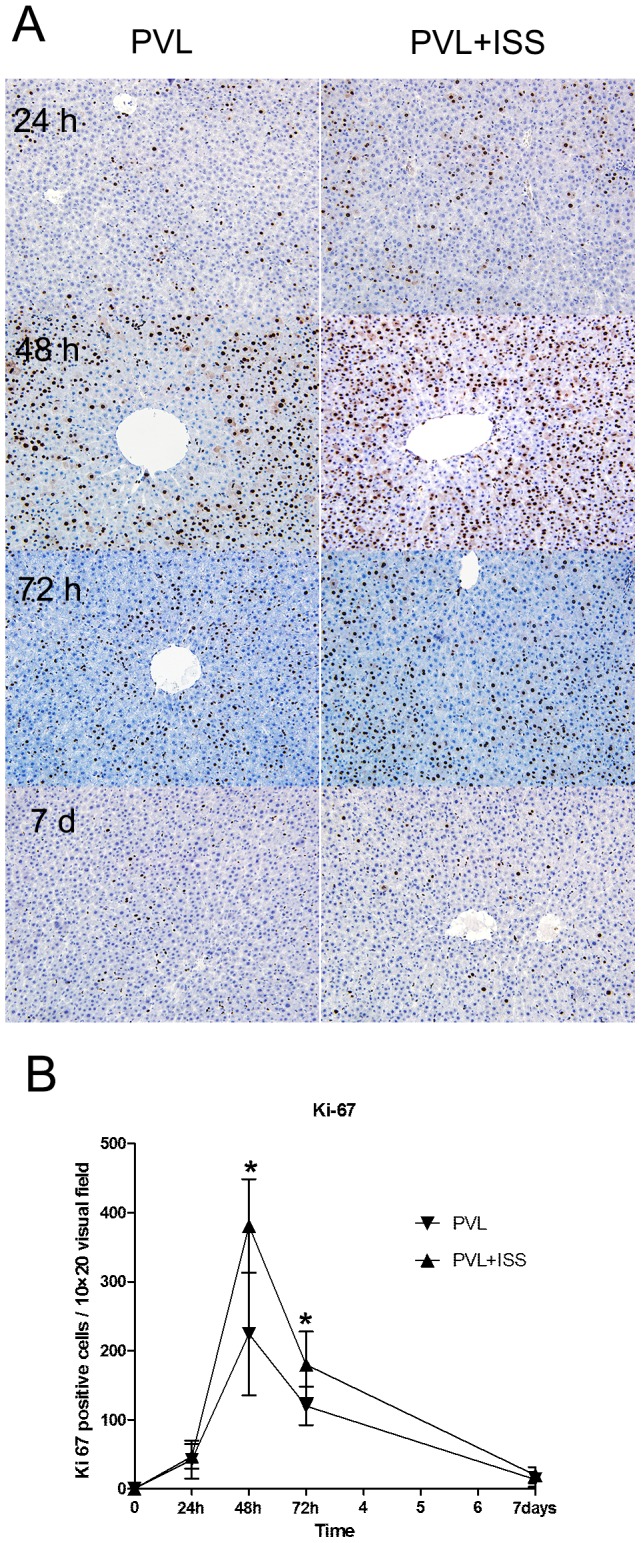
The number of Ki-67-positive hepatocytes in regenerating lobes after PVL and PVL+ISS.(A) Immunohistochemical staining for Ki-67 in regenerating lobes at all time points. Hepatocytes with nuclear deposition of brownish pigment were considered positive (original magnification 200×). (B) The regenerating lobes were analyzed for Ki-67-positive hepatocytes at all time points. The number of positive hepatocytes per visual field (200×) is presented. The increase in Ki-67-positive cells shows a significant difference at 48 and 72 h (*p<0.01 and *p<0.05, respectively), while no significant difference was observed at 24 h and 7 days.